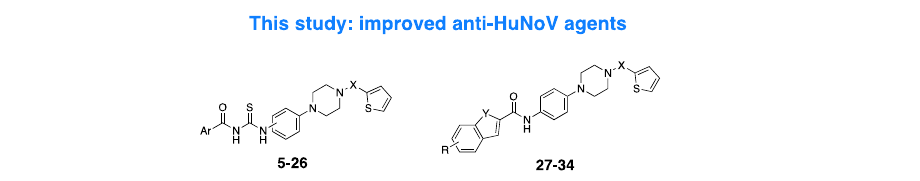
Figure 1. Previously identified biochemical ( 1–2 ) and antiviral ( 3–4 ) hits, and summary of the chemical modifications explored in this